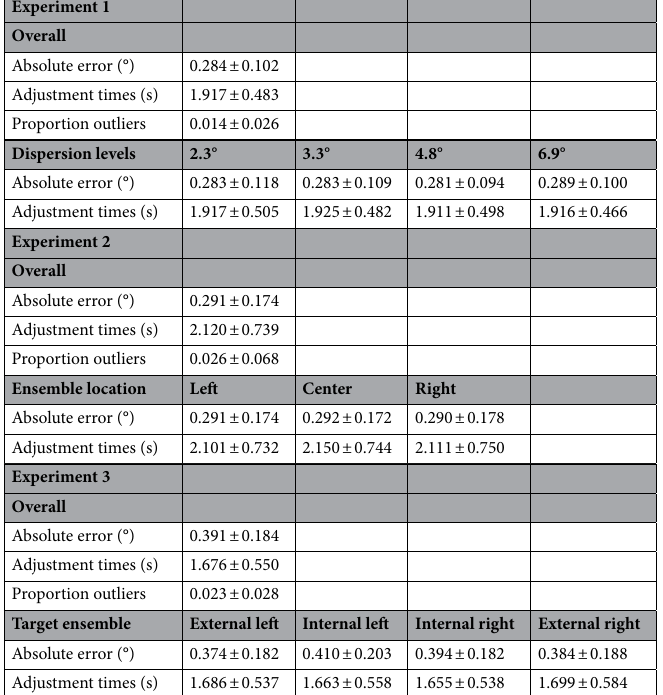
Table 1. Summary of the performance in size adjustment tasks. For each experiment and condition, the overall absolute adjustment error is reported in degrees (°) and the average adjustment times in seconds